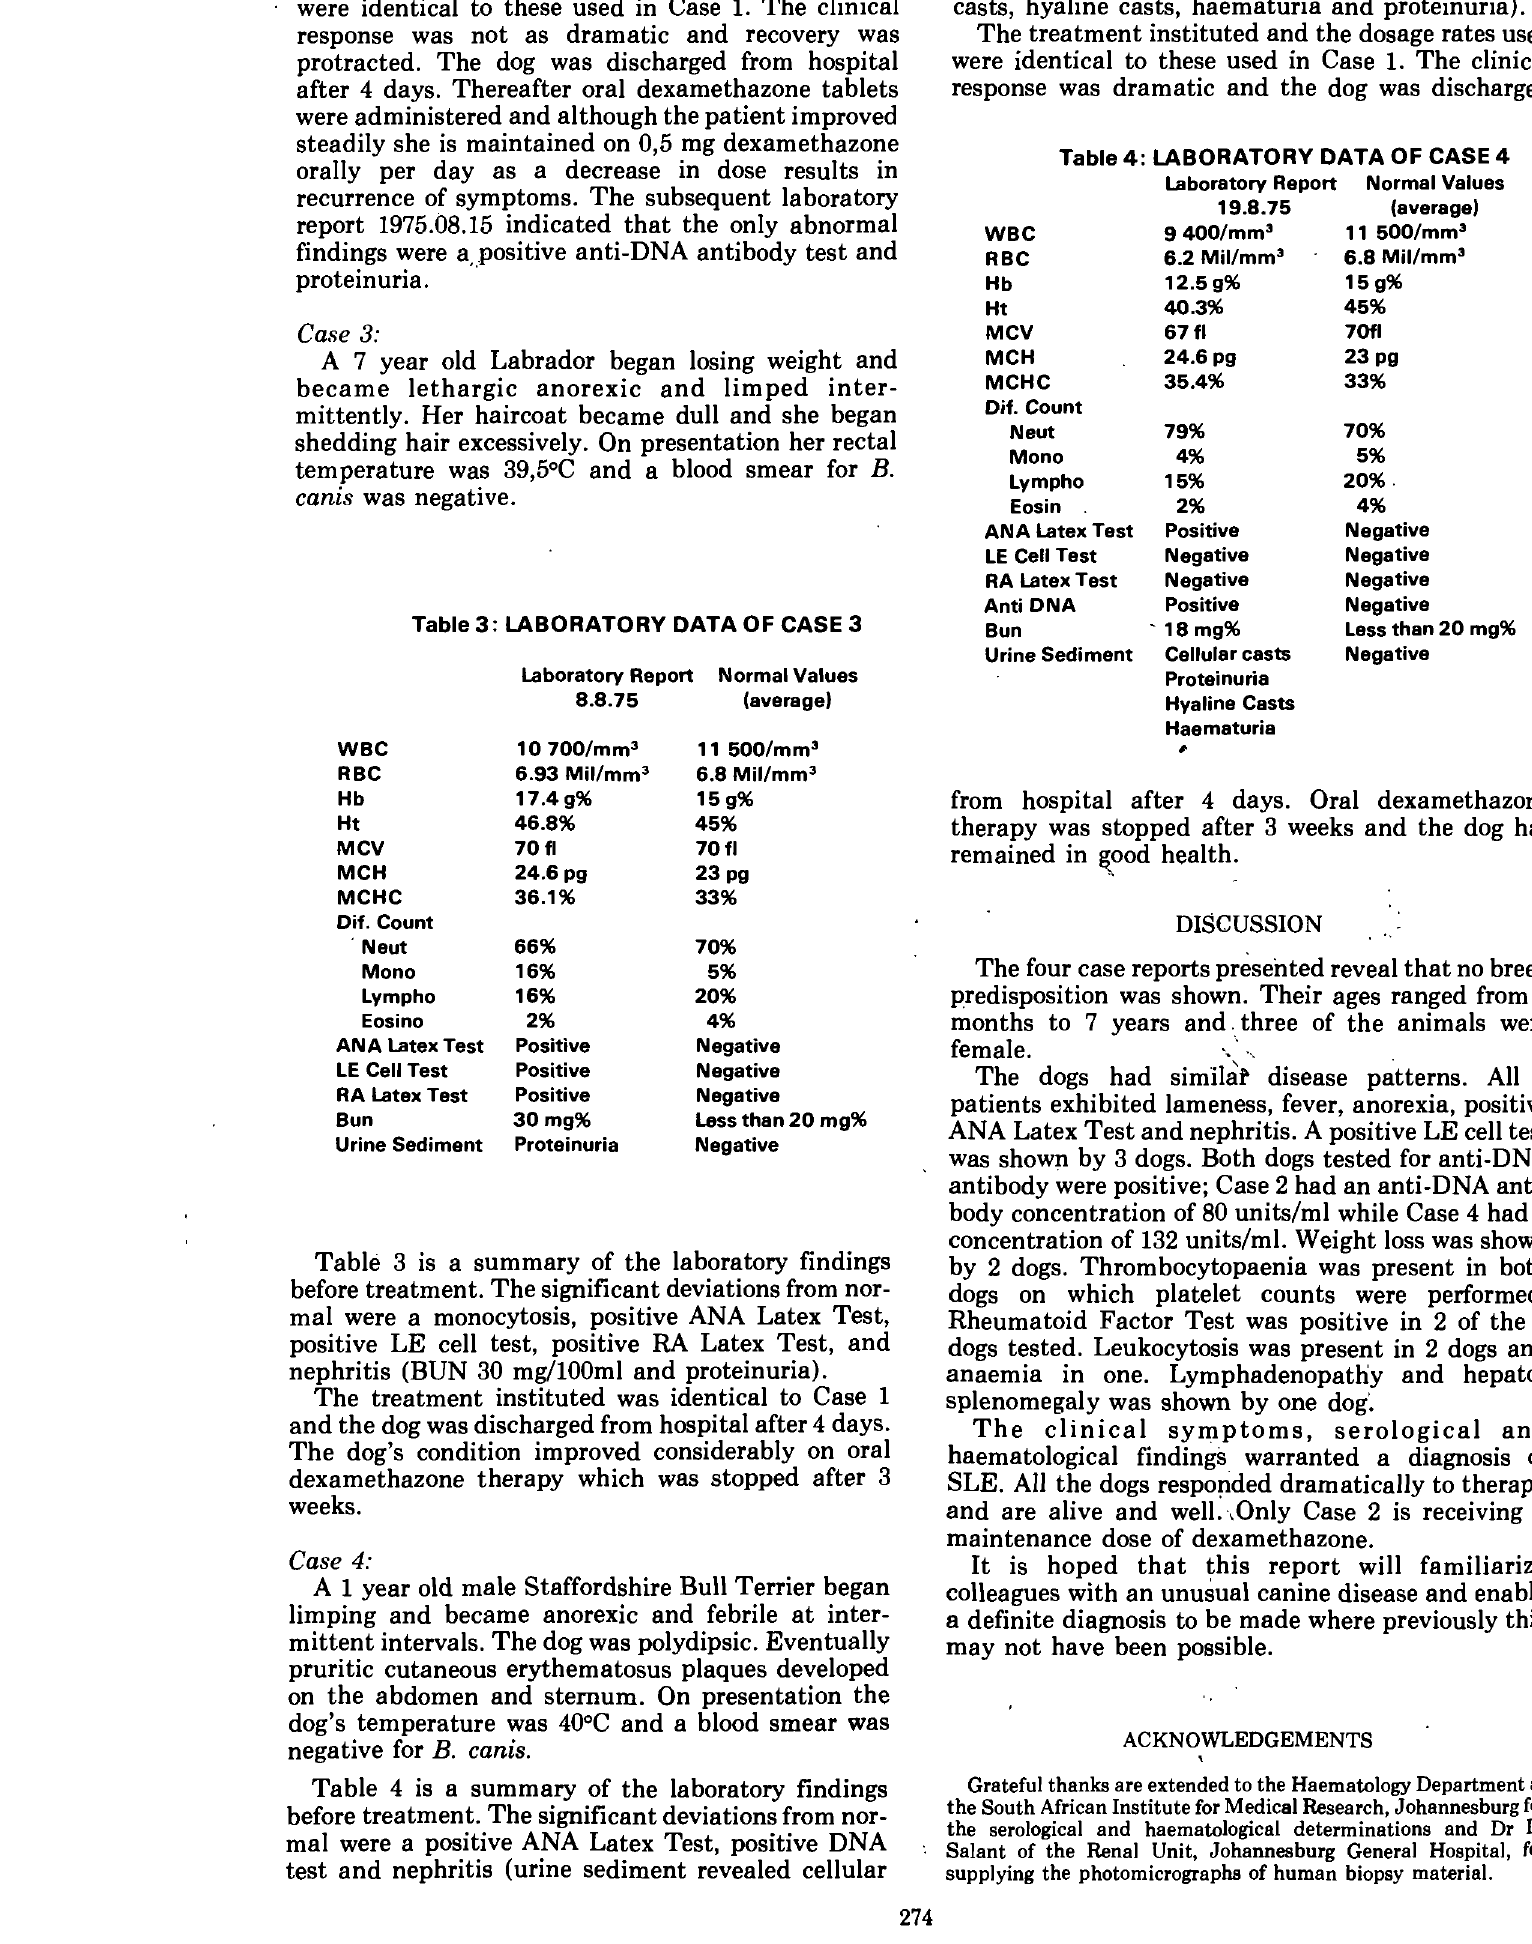
Table 4: LABORATORY DATA OF CASE